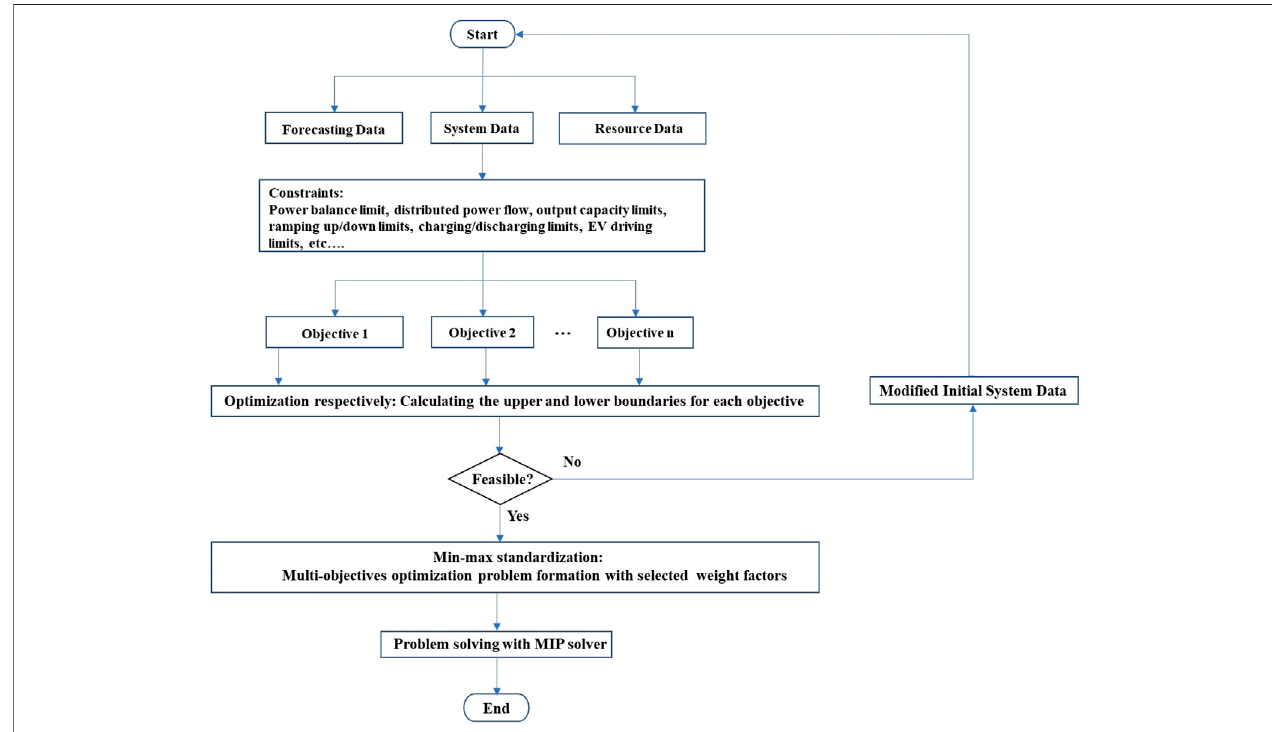
FIGURE 3 | Flowchart of the proposed multi-objective optimization model and the solution process.